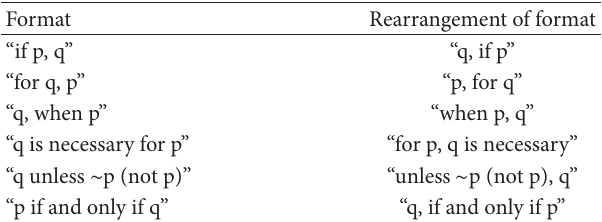
Table 2: Conditional structure